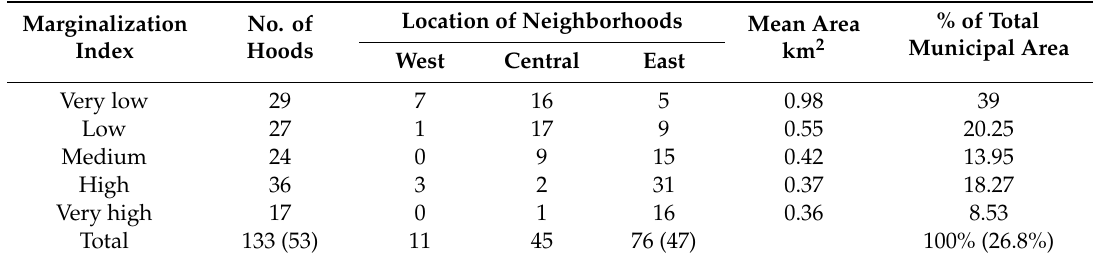
Table 4. Quantitative distribution of the marginalization in zones (elaborated by the authors with data from Conapo, 2015 [44]).